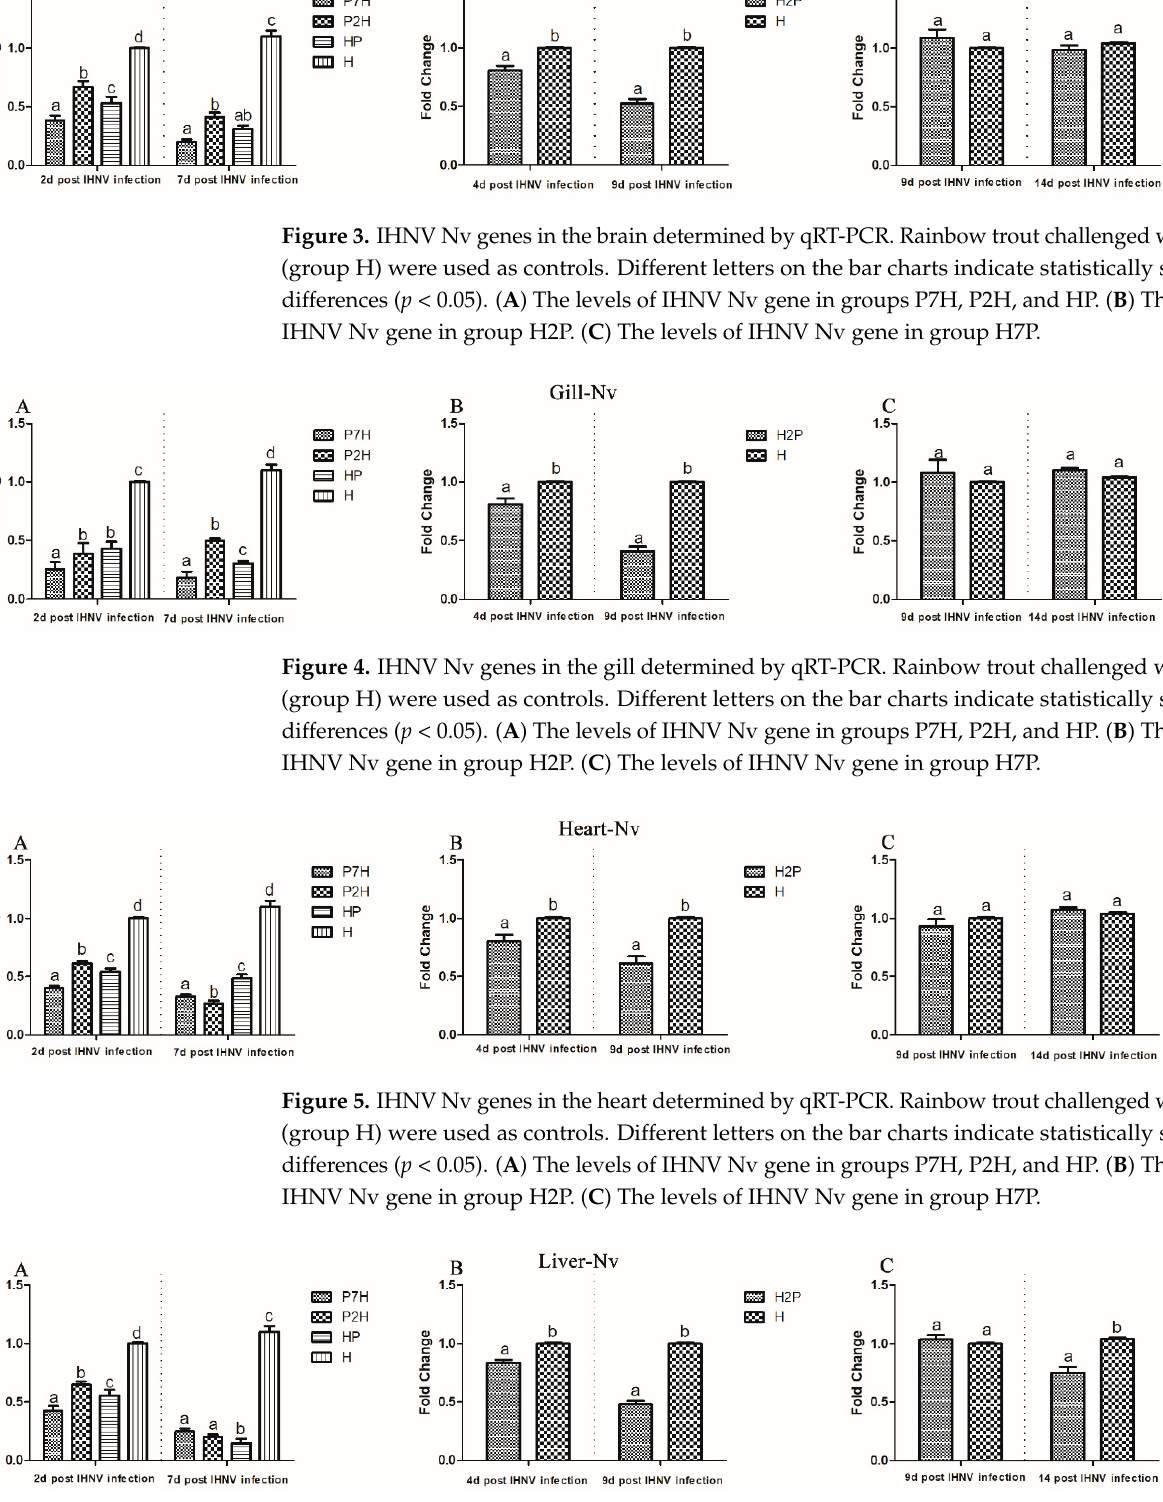
Figure 6. IHNV Nv genes in the liver determined by qRT-PCR. Rainbow trout challenged with IHNV (group H) were used as controls. Different letters on the bar charts indicate statistically significant differences ( p < 0.05). ( A ) The levels of IHNV Nv gene in groups P7H, P2H, and HP. ( B ) The levels of IHNV Nv gene in group H2P. ( C ) The levels of IHNV Nv gene in group